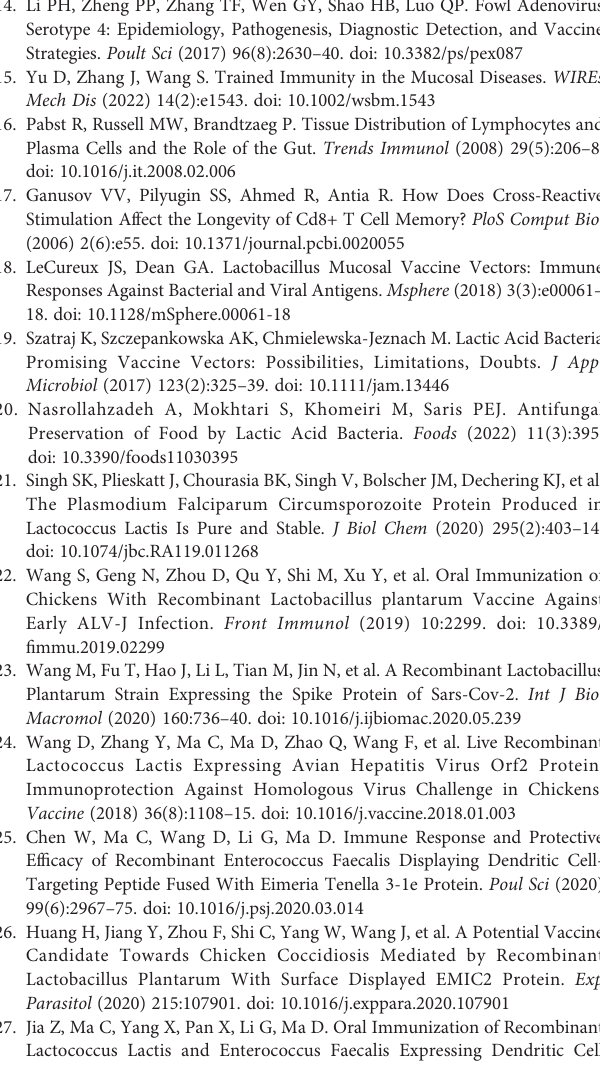
Supplementary Figure 1 | Western blot detection of viral proteins. Detection of viral protein in liver tissues from each group on the 5dpi. Fiber2 polyclonal antibody (1:2000) and HRP-labeled goat anti-rabbit secondary antibody (1:2000) were used for detection. b -actin was usedasan internal referencefor detection. Theamountof viral protein in the four recombinant lactic acid bacteria immunization groups was lower than that in the control group. Supplementary Figure 2 | Gross examination of heart, spleen, and kidney from chickens. The gross pathological changes in infection control, L. lactis /pTX8048, and E. faecalis /pTX8048Groups were obvious. Their heart and kidneys were signi fi cantly enlarged, and the spleen had congestion and enlargement simultaneously. The pathological lesions in groups L. lactis /pTX8048-Fiber2-CWA, L. lactis /pTX8048-DCpep-Fiber2-CWA, E. faecalis /pTX8048-Fiber2-CWA and E. faecalis /pTX8048-DCpep-Fiber2-CWA were relatively